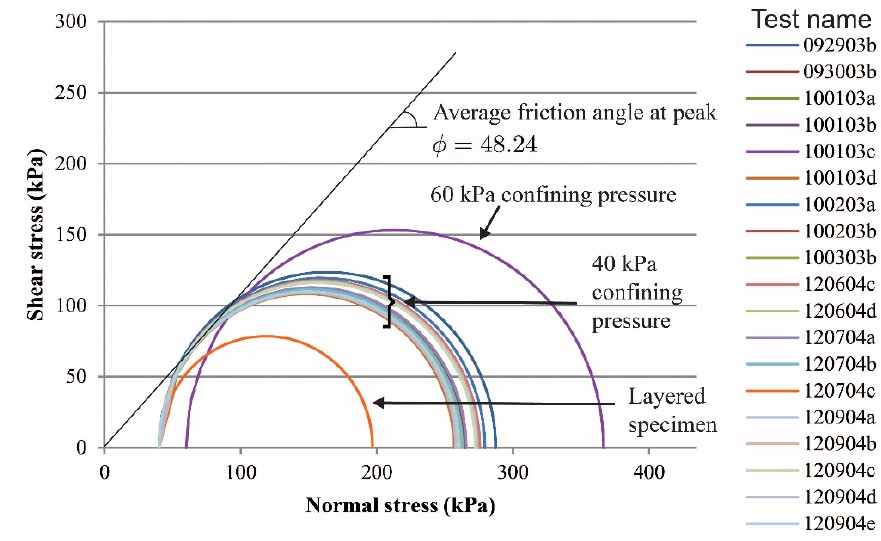
Figure 5 . Mohr’s circles of sand specimens prepared by the vibratory compaction method. Figure 5. Mohr’s circles of sand specimens prepared by the vibratory compaction method.